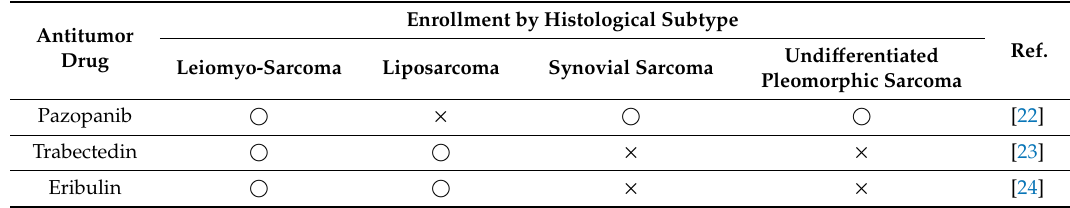
Table 2. Histological subtypes of the STS patients enrolled and excluded in phase 3 clinical trials of late-line